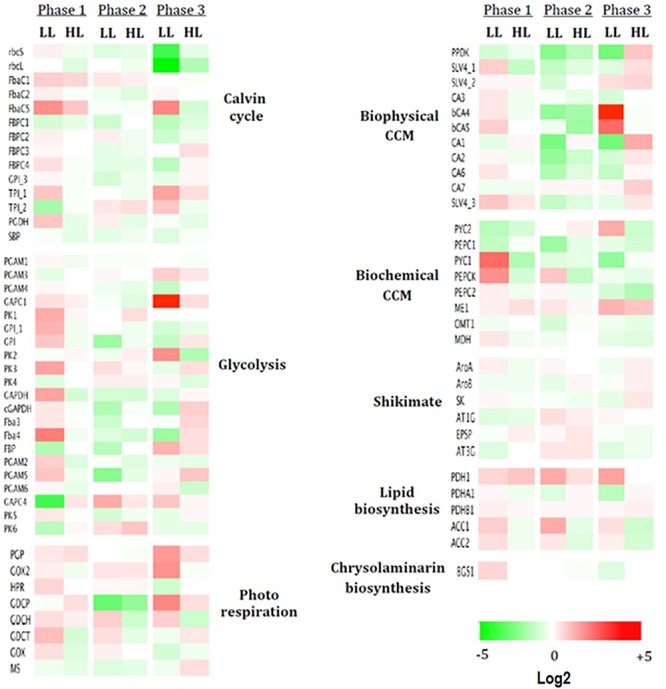
Dysregulated heatmap of up- or down-regulated genes under different light intensities. Are presented the log2 expression pattern of 74 genes related to carbon metabolic pathways, with the greatest differences in expression (red: high, green: low). Columns represent three growth phases under low light (LL) and high light (HL). Heatmap performed using Netwalker 1.0.